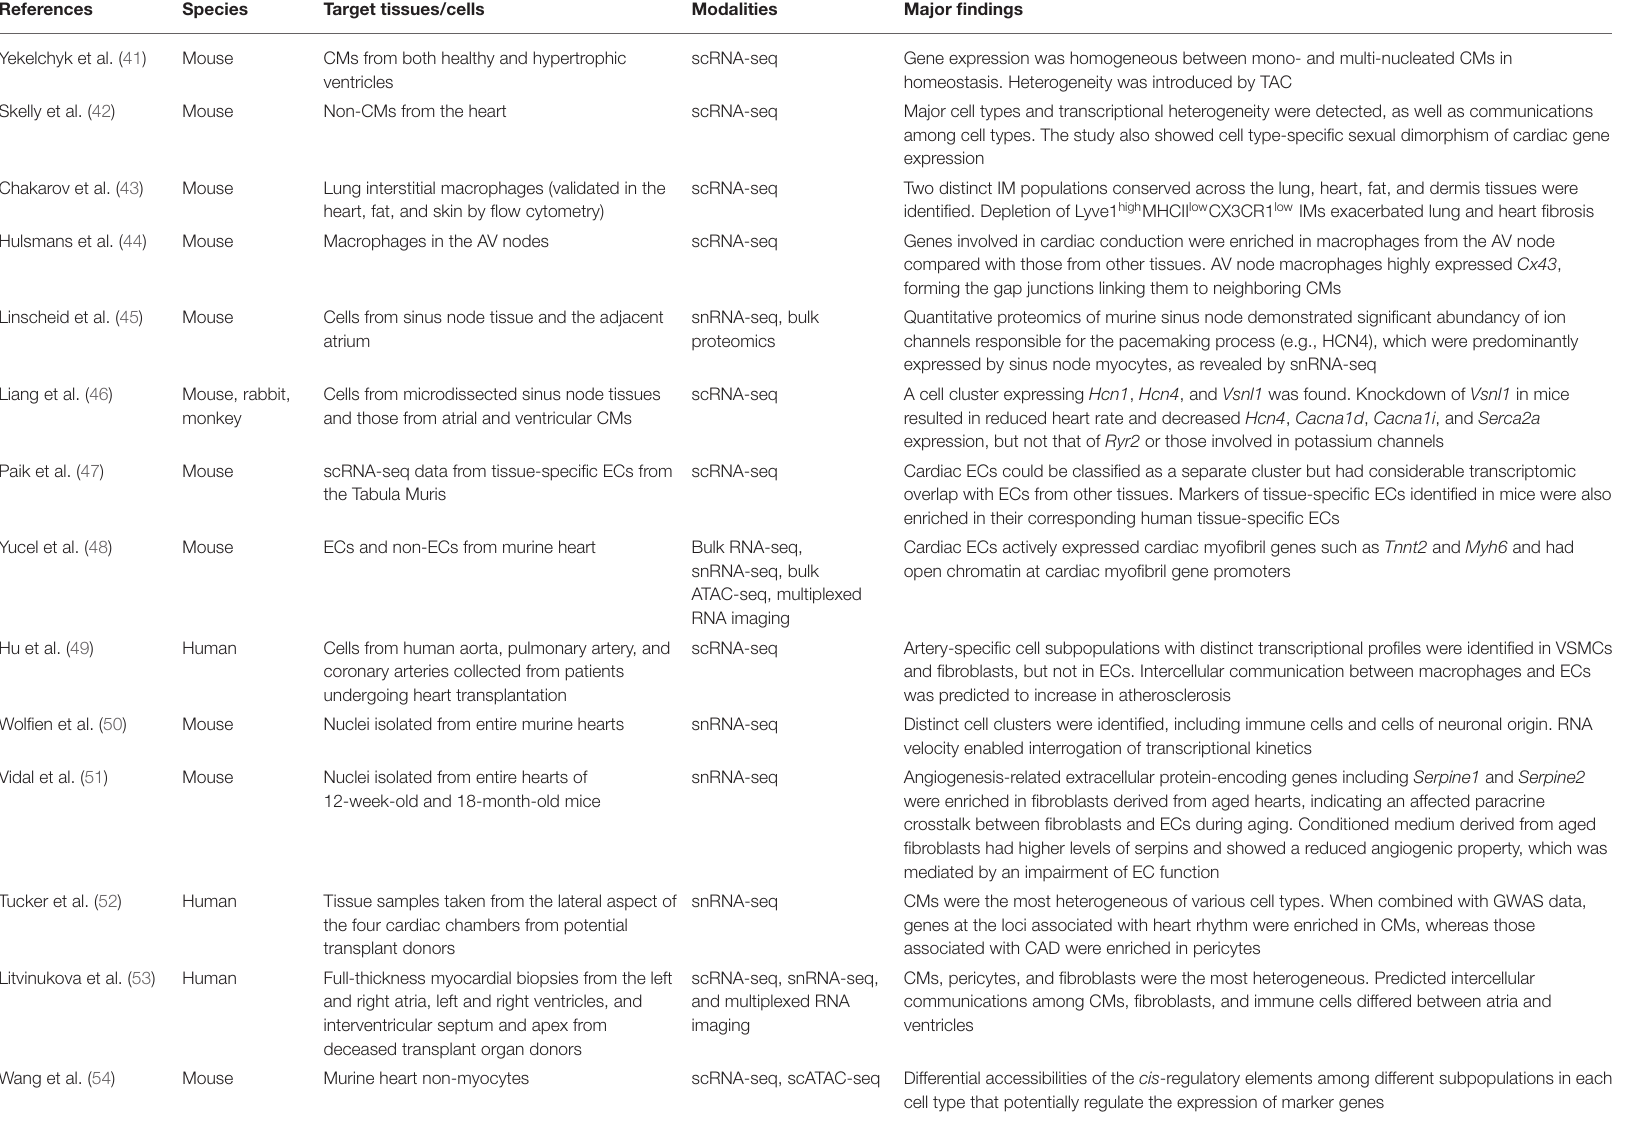
TABLE 2 | Summary of studies of homeostasis of the adult